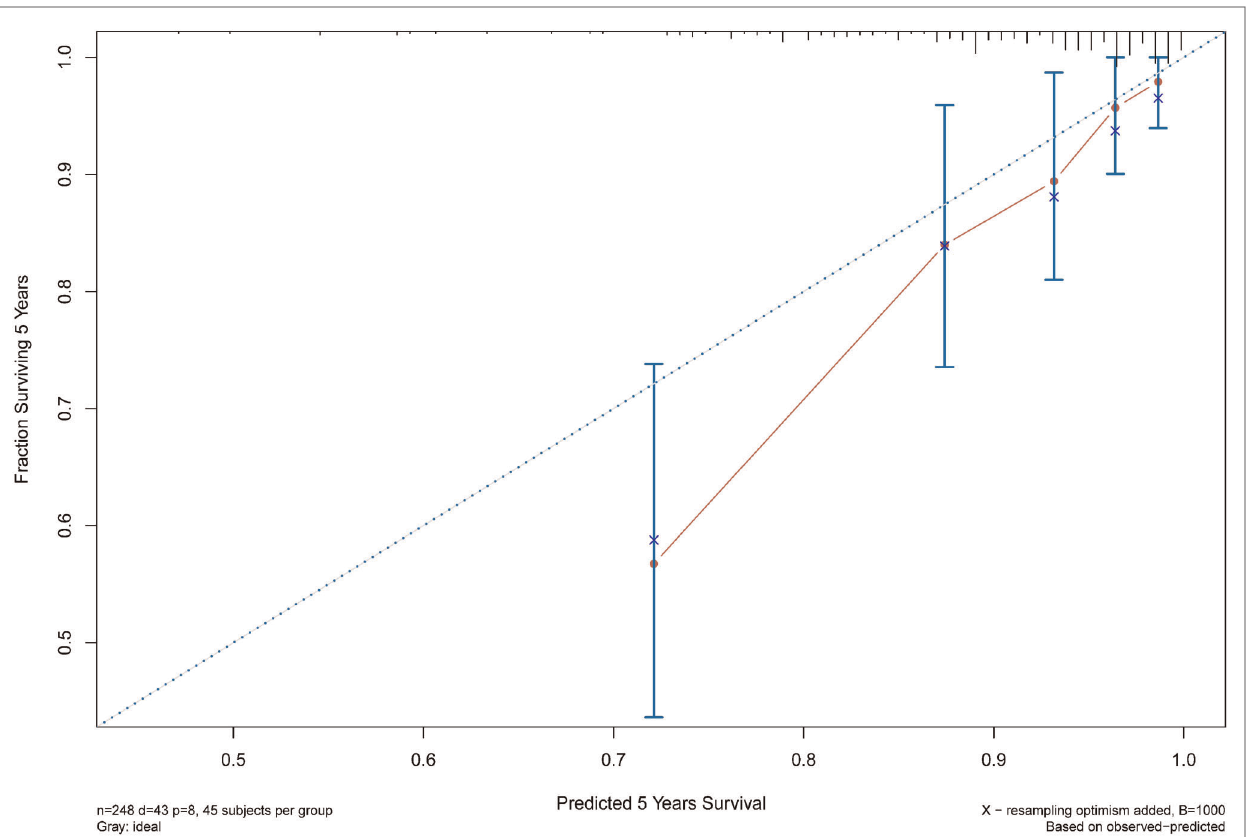
FIGURE 5 | The calibration curves for evaluation of the consistency between the actual and the predicted hip survival rates. Satisfactory consistencies were showed on 5-year survival